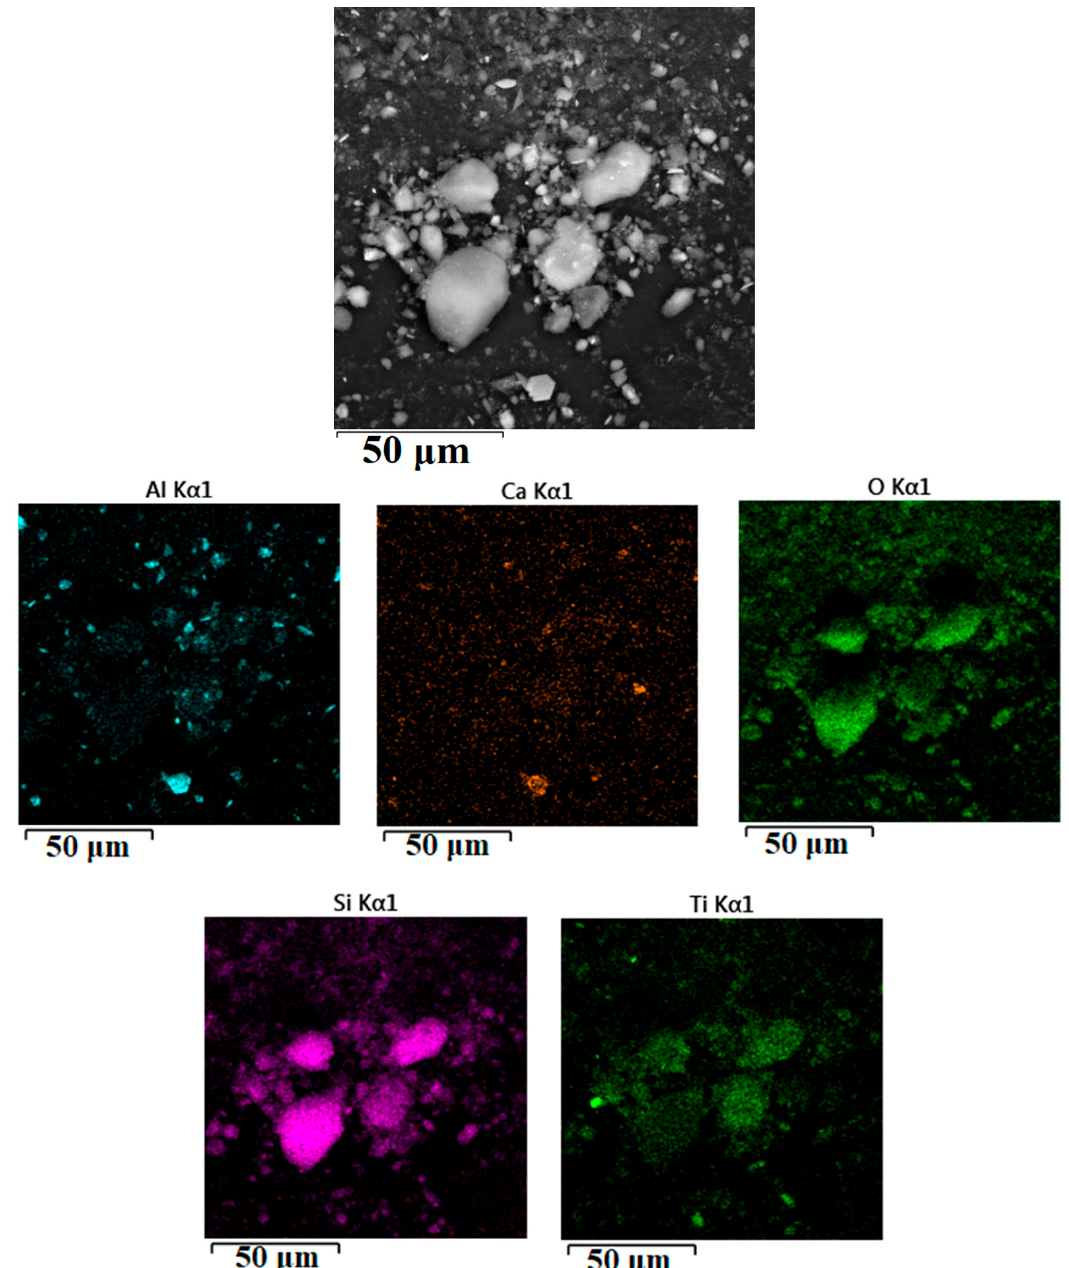
Figure 6. SEM images with the distribution of elements in the solid residue obtained by the leaching of the WAT sample using 10% HCl at 150 °C and S:L = 1:11 for 60 min.